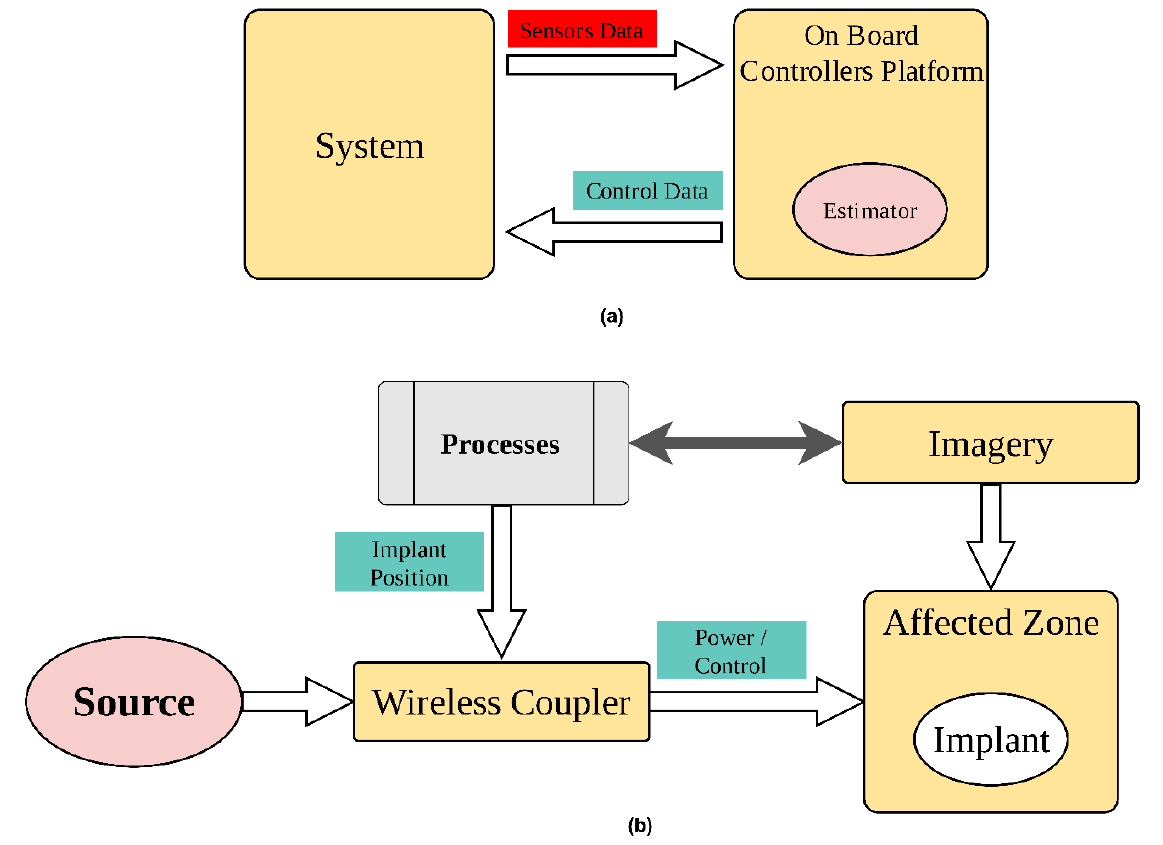
Figure 3. Iterative real-time matching in automated system: (a) Conceptual representation of iterative matching; (b) Example of interactive autonomous image guided drug release